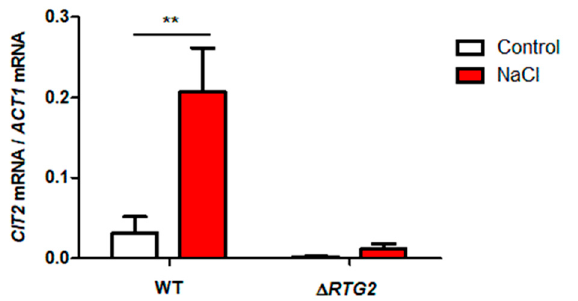
Figure 5. CIT2 expression under high osmotic environment. Wild-type (WT) and ∆ RTG2 cells, grown overnight in YPD medium, were diluted to 0.1 OD 600 in fresh liquid YPD with or without 0.8 M sodium chloride (NaCl). After 5 h, cells were collected for RNA extraction, and mRNA levels were measured by quantitative PCR. The amount of CIT2 mRNA was normalized with ACT1 mRNA and calculated in relative units (2 − ∆ Ct ), where ∆ Ct is the Ct sample − Ct reference gene and Ct is the threshold cycle. Unpaired Student’s t -test: a statistically significantly difference with ** p < 0.01 when comparing wild-type untreated cells versus NaCl-stressed cells from three independent experi- ments.